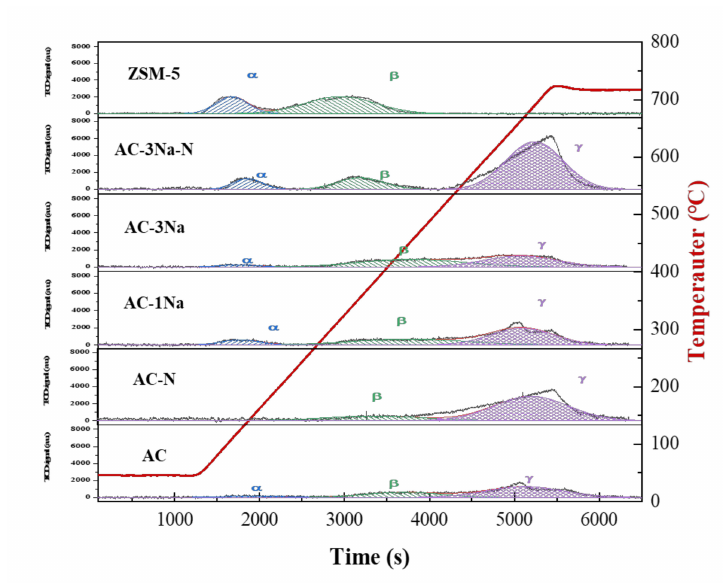
Figure 4. NH 3 - temperature programmed desorption (TPD) profiles of fresh ACs and ZSM-5 zeolite.